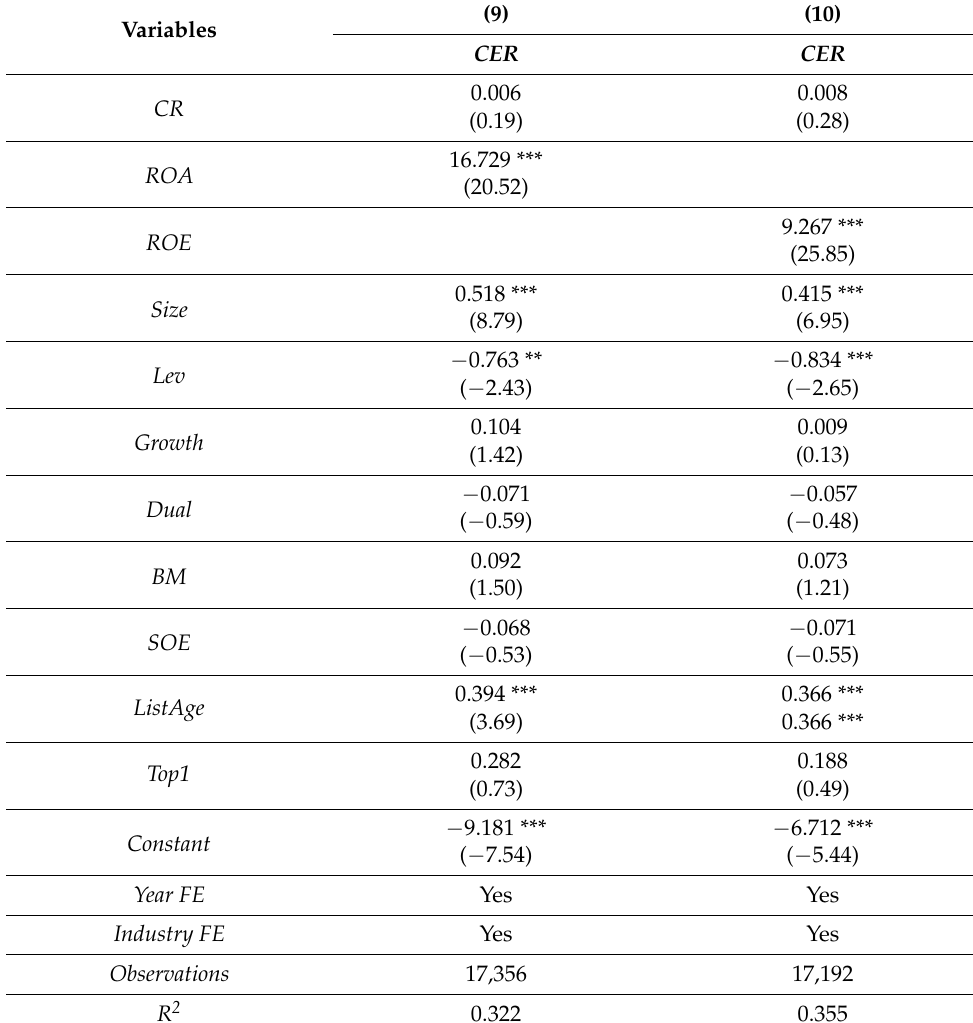
Table 7. Regression results of enterprise supply chain power, business performance, and environ- mental